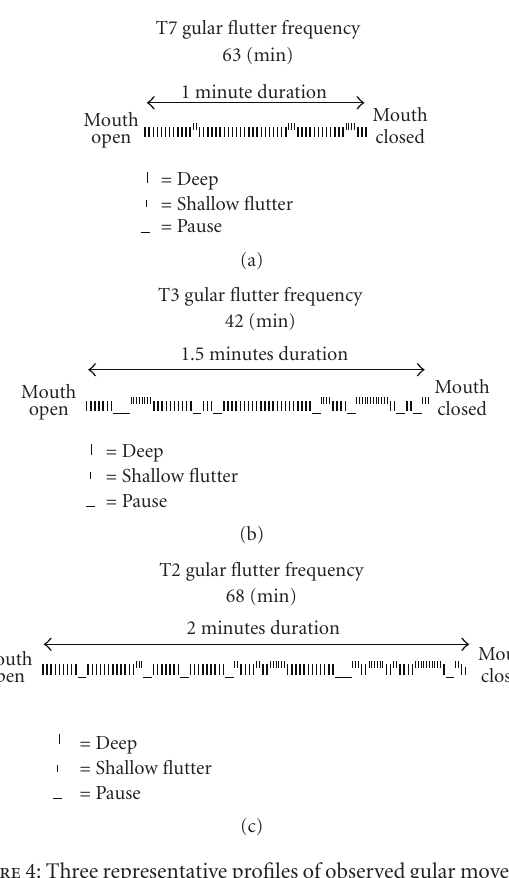
Figure 4: Three representative profiles of observed gular movement by large dragons during the heat of the day. The long vertical bar represents a deep flutter; short bars are shallow flutter and horizontal bars indicate no flutter movements. The horizontal arrow depicts the duration of a gular flutter